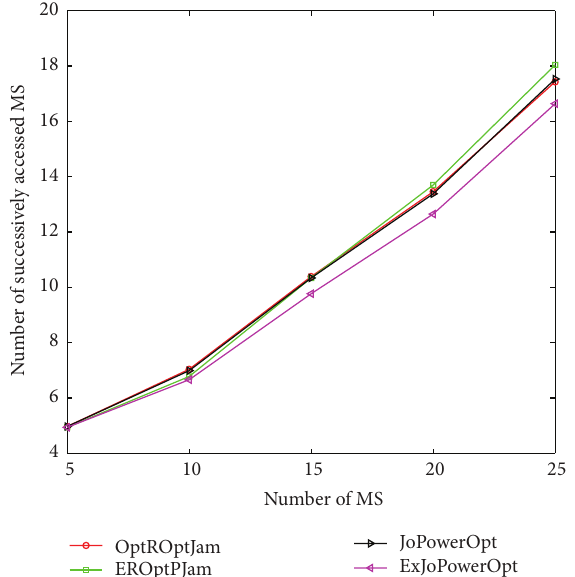
Figure 8: Number of successively accessed MS number versus number of MS.